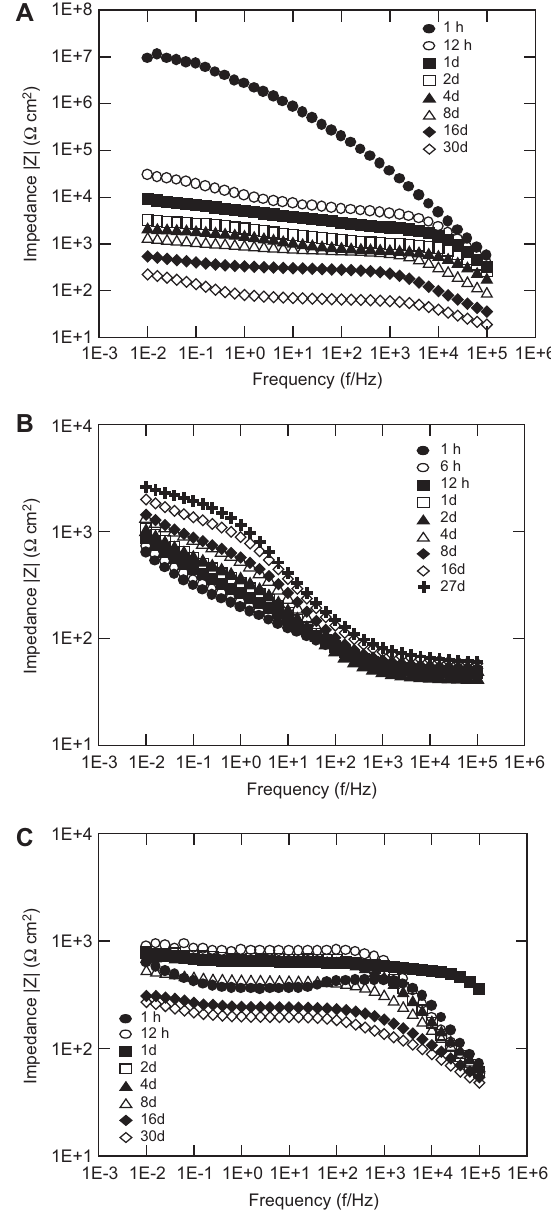
Figure 3 EIS of chlorinated rubber lacquer (A), unsealed sprayed ZAZA coatings (B), and sealed sprayed ZAZA coatings (C).